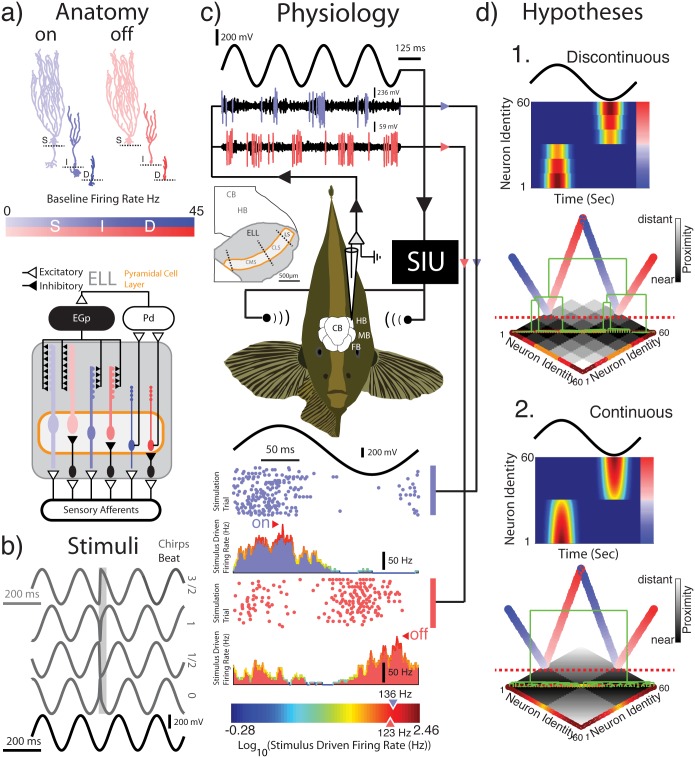
Establishing a functional classification using naturalistic communication stimuli.A: There are two types of pyramidal neurons, On- (blue) and Off- (red) type, which can be distinguished anatomically by the presence and absence of basilar dendrites, respectively (top). On- and Off-type pyramidal cells can furthermore be subdivided into six classes: On and Off-type superficial (S) intermediate (I) and deep (D) types which each exhibits different sized apical dendritic trees. There is a strong negative correlation between the size of the apical dendritic tree and the baseline (i.e., in the absence of stimulation) firing rate (S1 Fig). The baseline firing rate is indicated by colour saturation as per the colour bar above the circuit diagram. At the circuit level (bottom) within the pyramidal cell layer (orange boarder) all neurons receive input from sensory afferents encoding the animal’s self-generated electric field. On-type cells receive direct inputs from these afferents whereas Off-type cells receive indirect input via local inhibitory interneurons. All neuron classes project to the midbrain torus Semicircularis (not pictured here) while only deep neurons project to praeminentialis dorsalis (Pd) which provides different degrees of inhibitory feedback to superficial and intermediate pyramidal neurons via the eminentia granularis pars posterior (EGP). B: The four chirp stimuli featured in this study are shown in dark grey. A 25 ms response window following chirp onset is also indicated by a light grey window for two On-type chirps (3π/2, π) and the two Off-type chirps (π/2, 0). The 5 Hz beat stimulus is shown in black. C: A stimulus waveform is played to an awake and behaving animal while recordings are obtained from pyramidal cells within the lateral segment (LS) of the ELL. Example recordings from one On-type and one Off-type neuron are shown in response to a 5 Hz beat. Spike waveforms identified using spike sorting software are indicated for each cell (blue and red). The spike times were used to generate raster plots and peristimulus time histograms (as seen below the experimental setup). Example cells have peak stimulus driven firing rates of 136 Hz (On-type) and 123 Hz (Off-type) and their responses to the beat are in anti-phase. The color gradient in the color bar (bottom) is indicative of the response magnitude of recorded units (i.e. On- or Off-type). The transition from blue to red reflects an increase in response magnitude as the logarithm in base 10 of the stimulus driven peak-firing rate. D: A priori it is unclear whether ELL pyramidal cells can be functionally classified based on their responses to natural communication signals alone. There are two hypotheses: 1. Responses form distinct clusters This is schematized by a heatmap of response magnitude showing distinct response profiles. Directly beneath a hierarchical agglomerative clustering algorithm applied to a pairwise distance matrix representing the above heatmap results in a dendrogram (green) which is clearly divisible into distinct groups (dashed red line). 2. Responses do not form distinct clusters and instead form a continuum. The response heat map as in 1 thus gives rise to one clear transition between On- and Off-type cells. In this case a hierarchical agglomerative clustering algorithm applied to a pairwise distance matrix representing the above heatmap results in a dendrogram (green) that is only divisible into two groups (dashed red line), each of which constitutes a continuum.